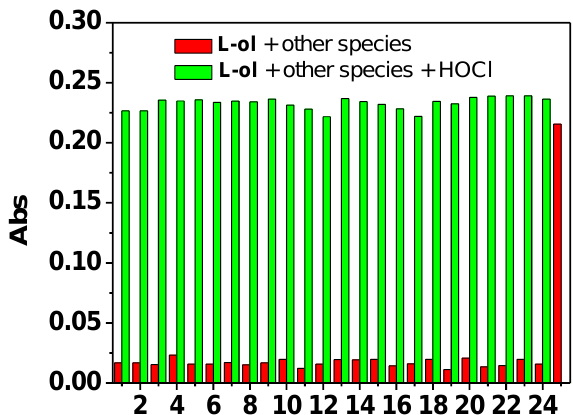
Figure 2. Absorption spectra responses of L-ol (10 μM) towards various competitive species (50 μM) in PBS aqueous buffer (DMF:PBS = 7:3, 20 mM, pH = 7.4). 1. Br – , 2. AcO – , 3. Cl – , 4. F – , 5. HSO 3 – , 6. HSO 4 – , 7. S 2 – , 8. NO 2 – , 9. NO 3 – , 10. OH – , 11. PO 42 – , 12. SO 32 – , 13. HCO 3 – , 14. Pi, 15. PPi, 16. HOCl, 17.